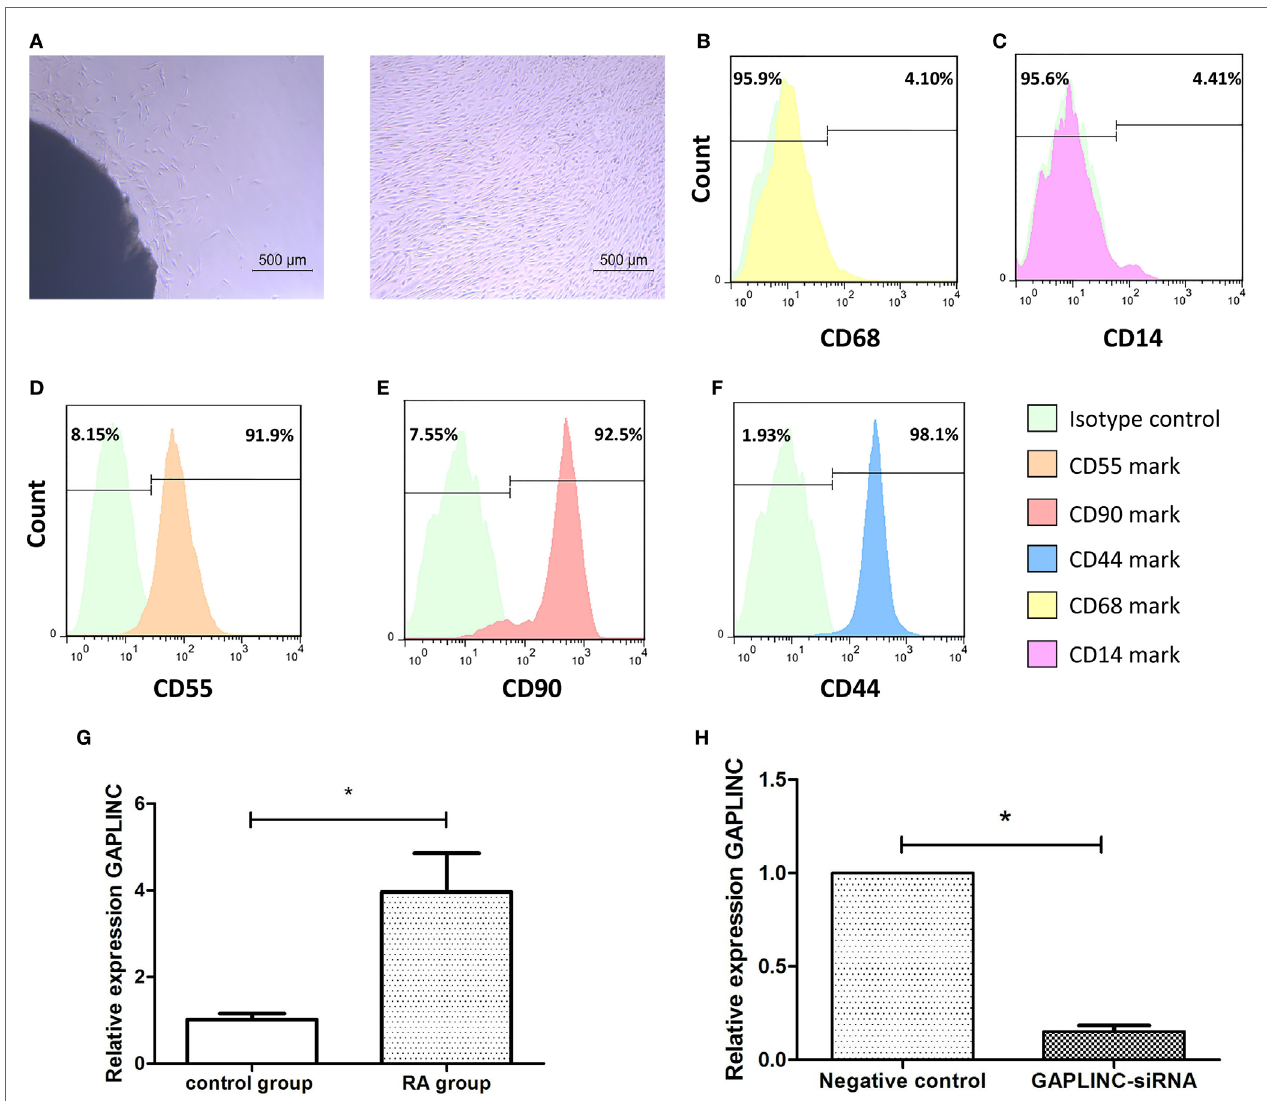
FigUre 1 | The cell characterization and the relative expression of LncRNA GAPLINC in different groups. (a) The morphology of rheumatoid arthritis (RA)-fibroblast- like synoviocytes (FLSs) were observed under the light microscope. The left graph showed primary fibroblast-like synoviocytes of RA crawled out from synovial tissues: the right graph showed the RA-FLSs at passages 3 have unique morphology. In (B–F) , the surface markers (CD55, CD90, CD44, CD14, CD68) of RA-FLS at passages 3 was detected by Flow cytometry. The left was Isotype control map; the right was surface mark map. Cells were identified by CD68 (B) and CD14 (c) negative staining, coupled with positive staining for CD55 (D) , CD90 (e) , and CD44 (F) staining. The diagrams revealed CD55, CD90 and CD44 expression rate of RA-FLS cell at passage 3 highly up to 90%. (g) LncRNA GAPLINC expression is increased in FLSs from RA patients than trauma groups analyzed by quantitative real-time reverse transcription PCR (qRT-PCR) (* P < 0.05). (h) GAPLINC-small interference RNA efficiently interferes with GAPLINC expression in RA-FLSs detected by (qRT-PCR) (* P <